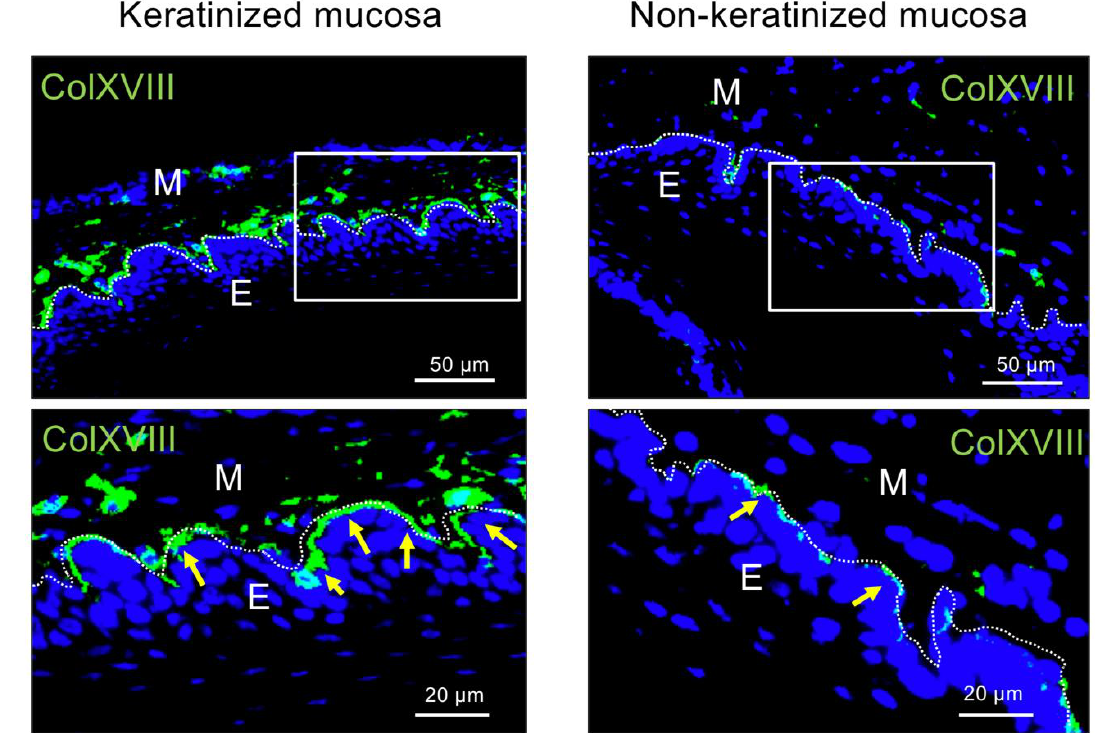
Figure 1. Immunohistochemical staining of type XVIII collagen in the basement membrane (BM) of keratinized mucosa and non-keratinized mucosa. All sections were cut in the coronal direction. Boxes indicate the area shown at higher magnification in the lower panels. Yellow arrows indicate the positive signal of type XVIII collagen. Note that type XVIII collagen (green) is highly expressed in keratinized mucosa. Nuclei were counterstained with DAPI (blue). E, epithelial tissue; M, mesenchymal tissue. Dashed lines indicate the basement membrane. Results are representative of three independent experiments.